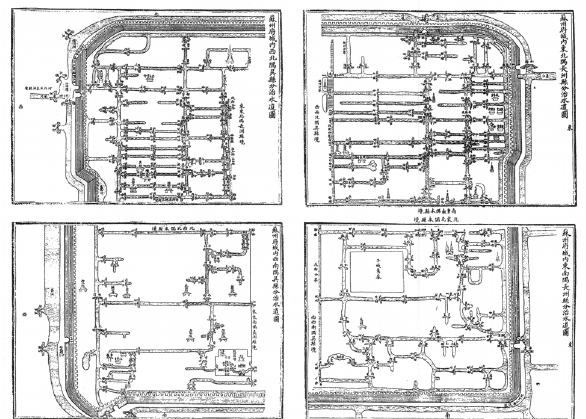
Figure 15. Original Map of Waterways in Suzhou, 1639, from 呉中水利全書 Wu-Zhong Shuili QuanshuDocuments on Water Conservancy in Wu ). (WZSLQS.1639)